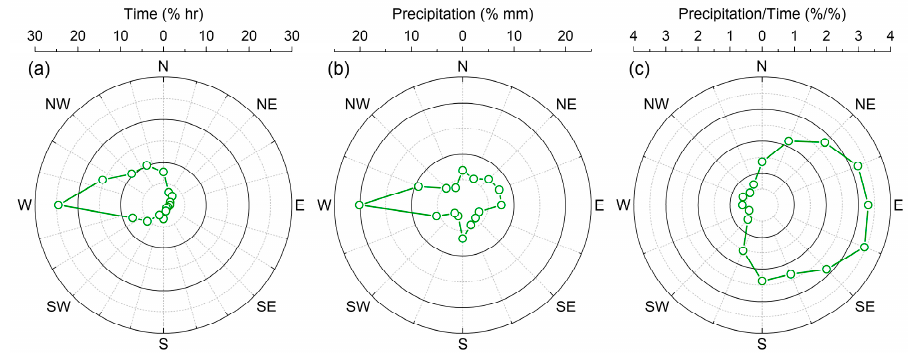
Figure A1. Wind sensor (every 1 h) and rain gauge (every 6 h) data from weather station in Punta Arenas airport during the period 1990–2017 plotted on the 16-point compass rose. ( a ) Frequency percentage of hourly wind direction observations (n = 232,277). There are 13,177 observational gaps (5.4% of all hours). ( b ) Precipitation percentage from each wind direction. Six-hour cumulative precipitation amount (n = 40,769) was divided by 6 to match with each hourly wind direction data prior to each precipitation measurement, assuming that wind in each of that 6 h contributes to that 6 h cumulative precipitation equally. There are 140 observational gaps (0.3% of all hours). ( c ) The quotient between precipitation percentage and time percentage for each respective wind direction. The weather station data are available for public download on [55].